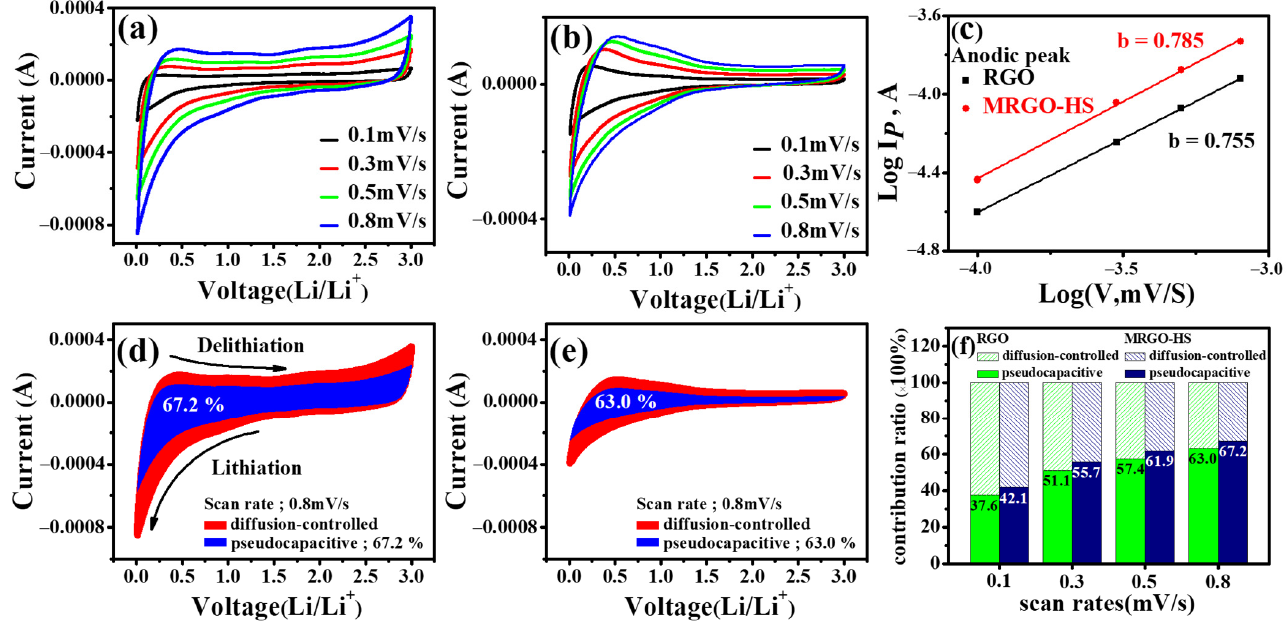
Figure 14. CV curves of ( a ) MRGO-HS and ( b ) RGO at different scan rates. ( c ) The log( i ) versus log( v ) plots of MRGO-HS and RGO. Pseudocapacitive (blue area) and diffusion (red area) contribution to the charge storage of ( d ) MRGO-HS and ( e ) RGO at 0.8 mV/s. ( f ) Proportion of pseudocapacitive contribution at different scan rates of MRGO-HS and